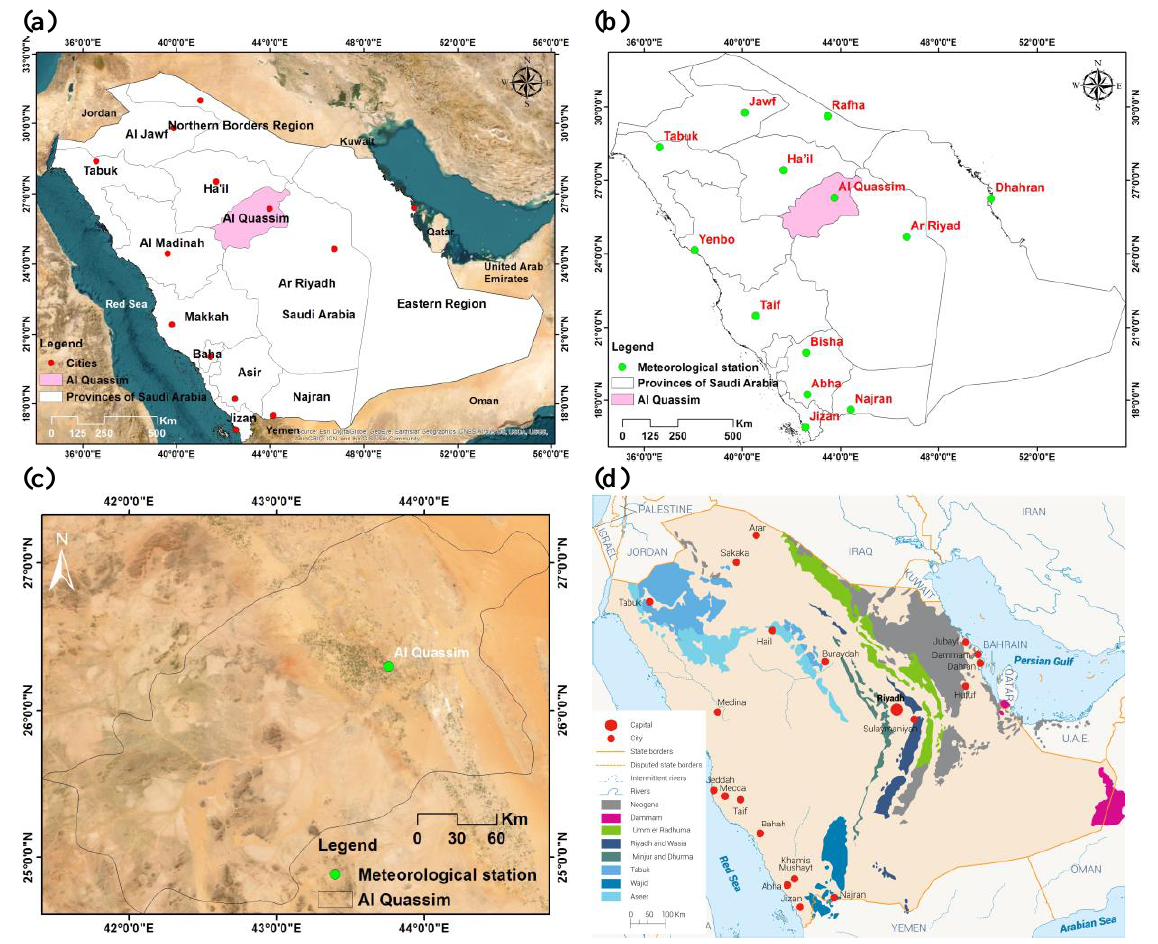
Figure 1. ( a ) Provinces of Saudi Arabia, ( b ) meteorological stations in Saudi Arabia, ( c ) the Al Quassim region, and ( d ) main aquifers in Saudi Arabia [Ministry of Environment, Water and Agriculture, 2018. National Water Strategy 2030].